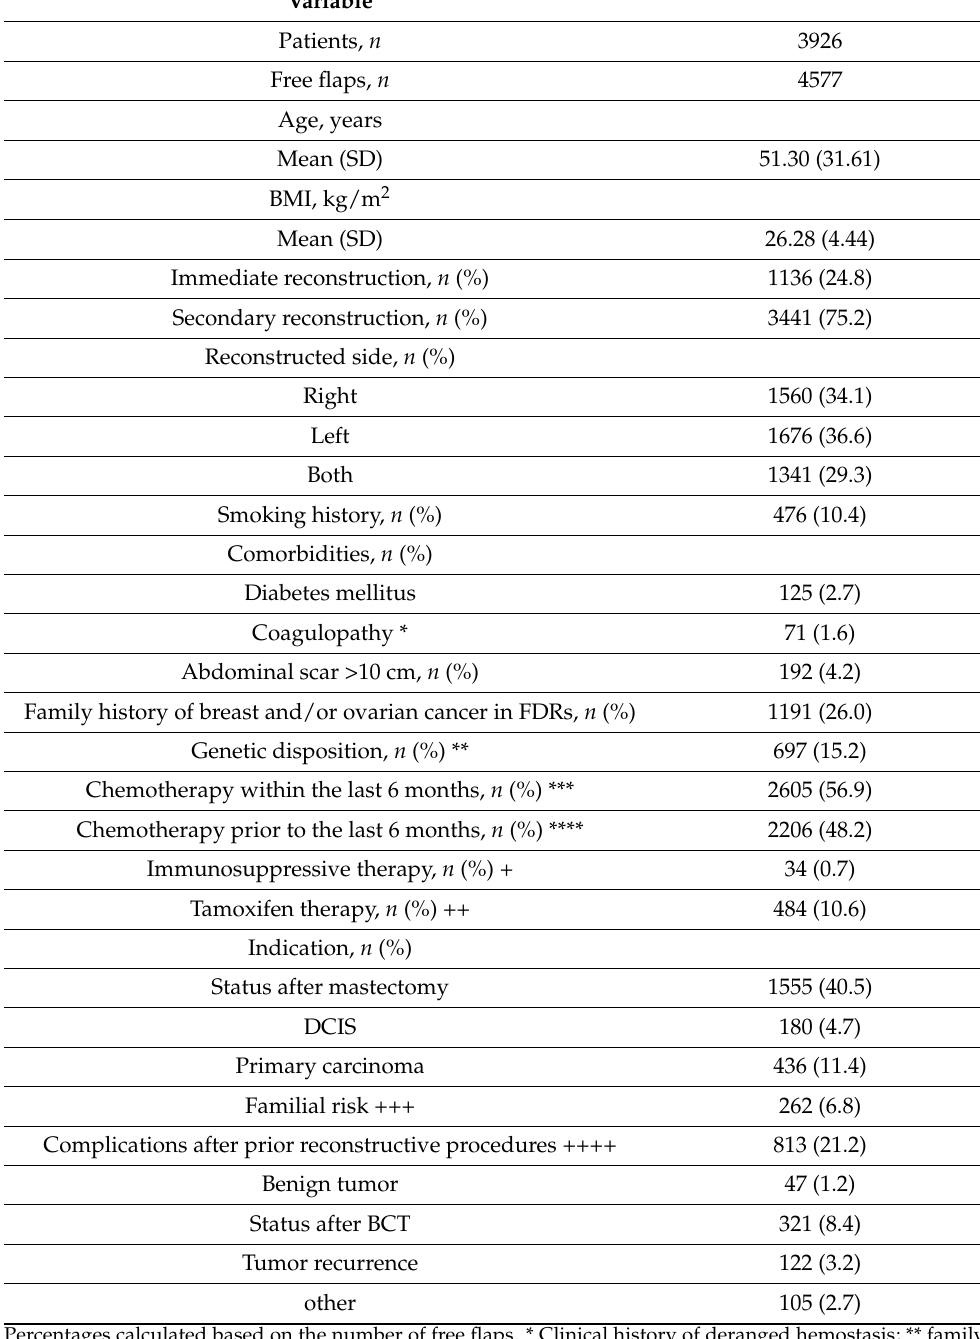
Table 2. Demographics and patient